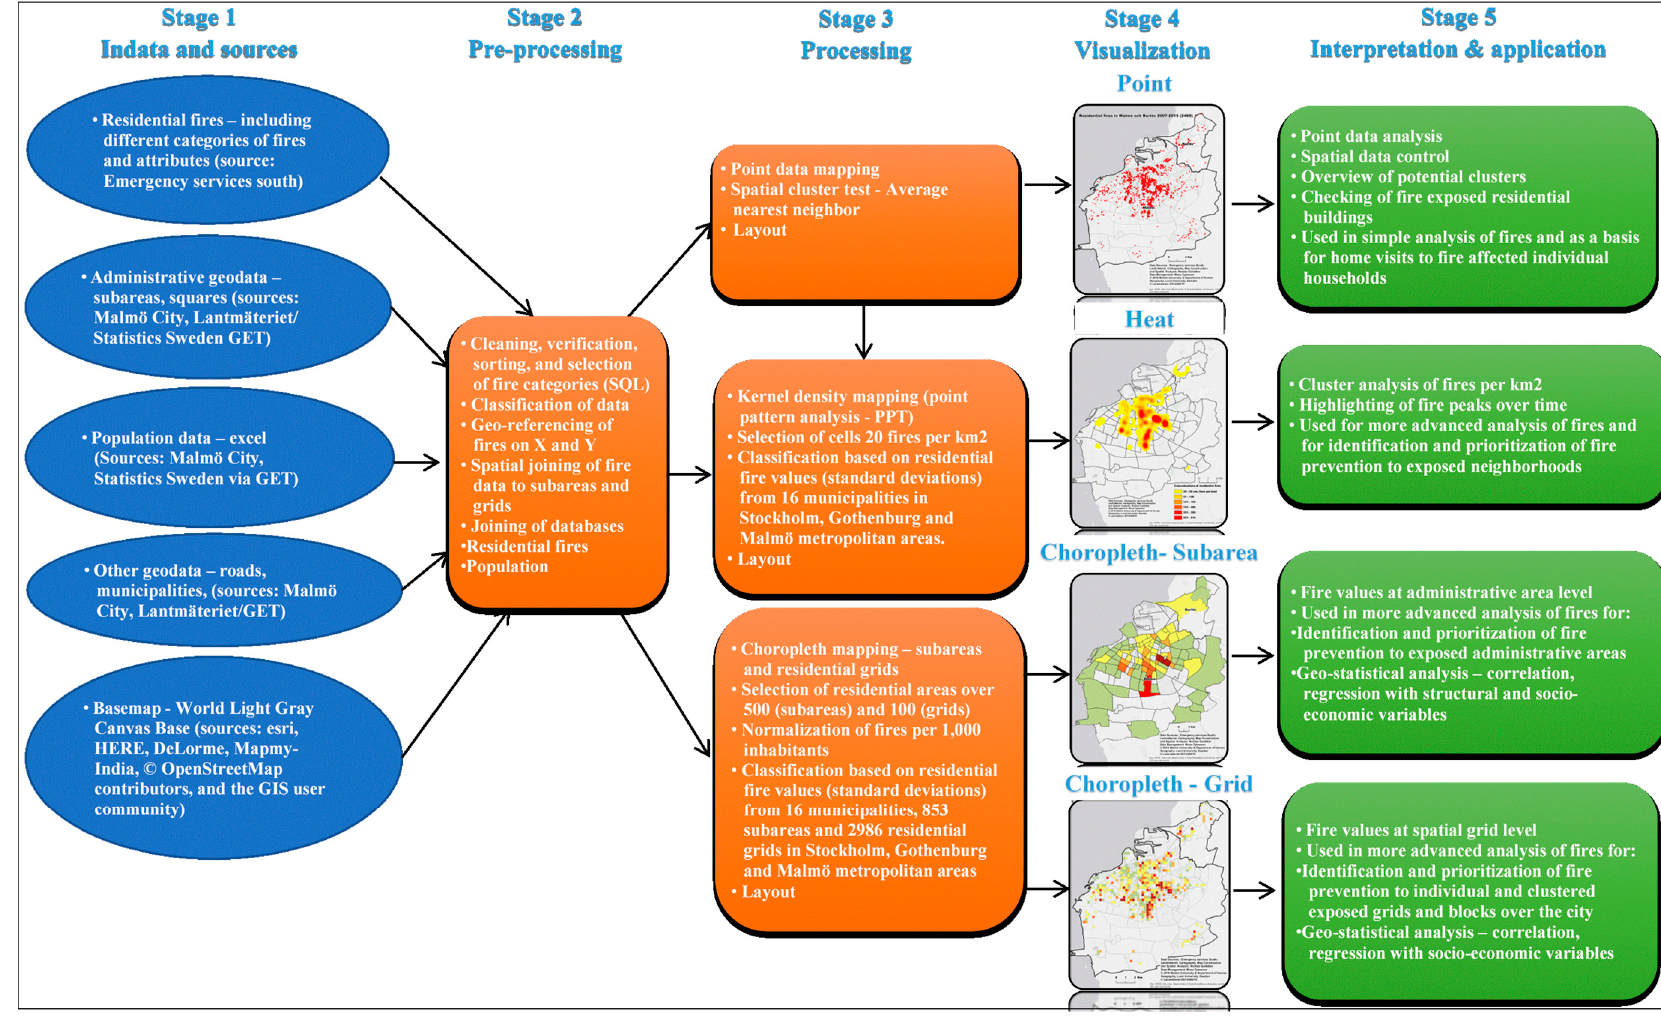
Figure 3. The process for developing different GIS-based visualization techniques and their applications in fire prevention .